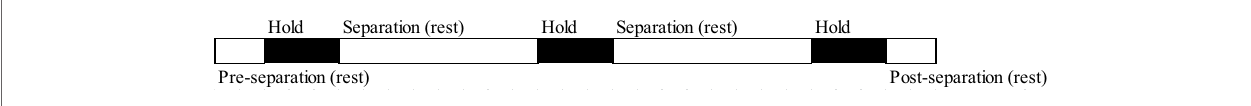
FigUre 1 | Procedure of separation of infant and parent.